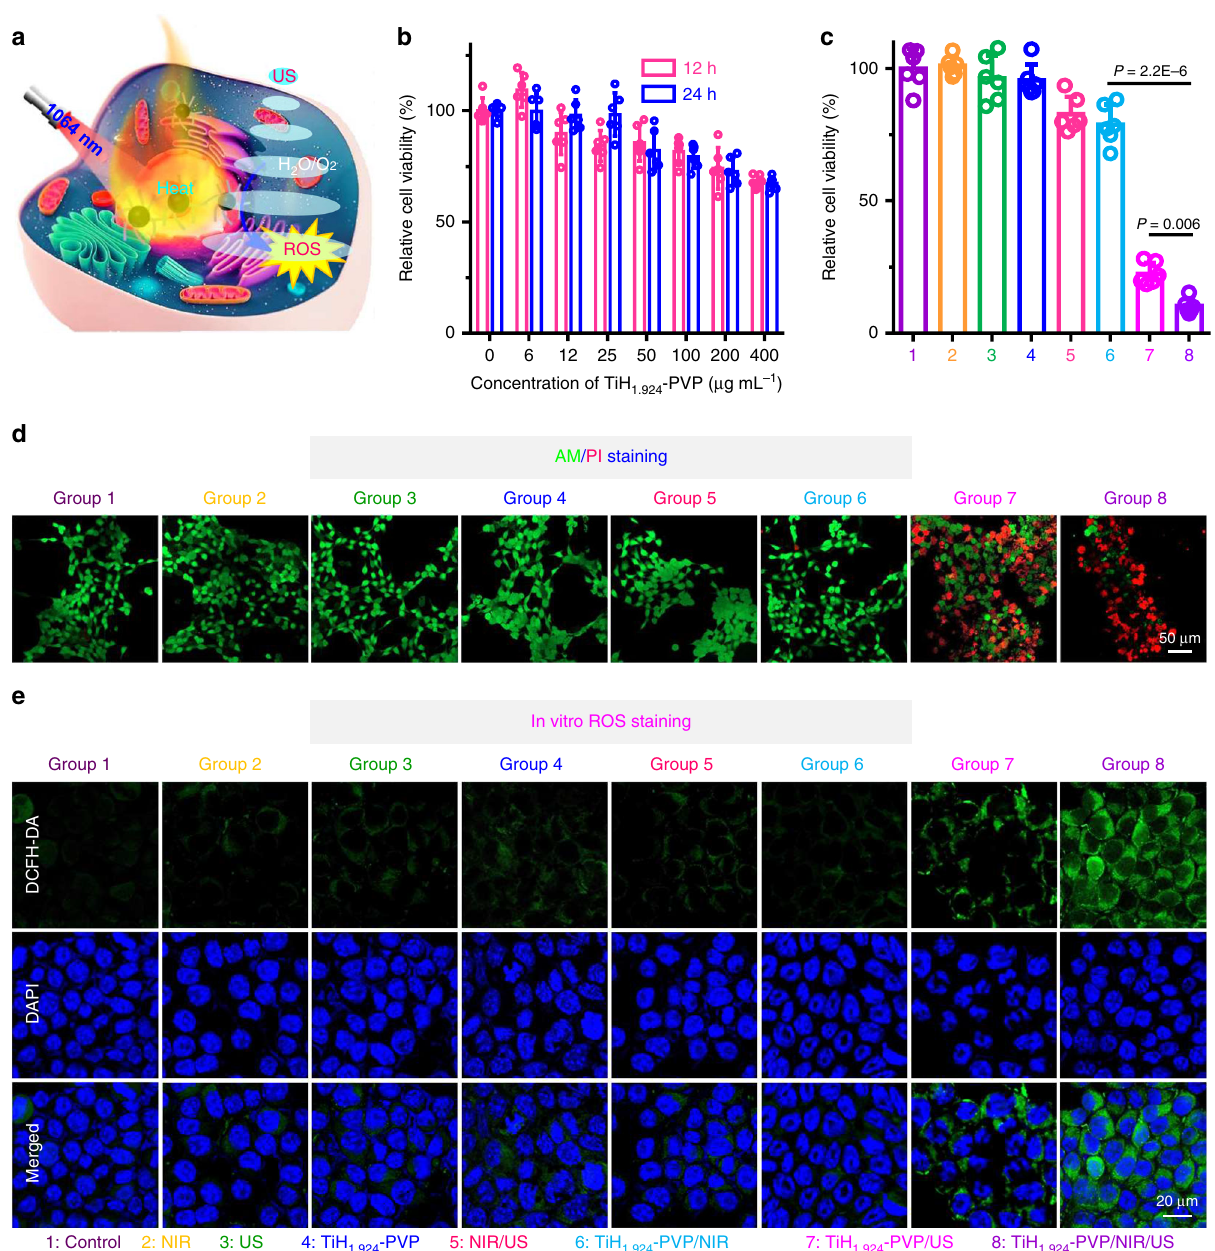
Fig. 4 In vitro mild PTT-enhanced SDT via TiH 1.924 -PVP. a Schematic illustration of TiH 1.924 -PVP for mild PTT-enhanced sonodynamic therapy. b Relative viabilities of 4T1 cells after incubation with various concentrations of TiH 1.924 -PVP for 12 h and 24 h ( n = 6 biologically independent samples). c Relative viabilities of 4T1 cells after different treatments, including control, TiH 1.924 -PVP, NIR, US, NIR/US, TiH 1.924 -PVP/NIR, TiH 1.924 -PVP/US, and TiH 1.924 -PVP/ NIR/US ( n = 6 biologically independent samples). d Confocal images of 4T1 cells stained with calcein AM (green, live cells) and propidium iodide (red, dead cells) after different treatments. e Confocal images of 4T1 cells stained with DCFH-DA after various treatments. The nuclei and intracellular ROS were stained by DAPI (blue) and DCFH-DA (green), respectively. TiH 1.924 -PVP: 50 µ g mL − 1 , NIR laser: 1064 nm, 0.8 W cm − 2 , 10 min, T < 42 °C; US irradiation: 40 kHz, 3 W cm − 2 , 1 min per cycle, 5 cycles. Data are presented as mean values± SD. Statistical signi fi cance was calculated with two-tailed Student ’ s t test ( c ). A representative image of three biological replicates from each group is shown in d , e